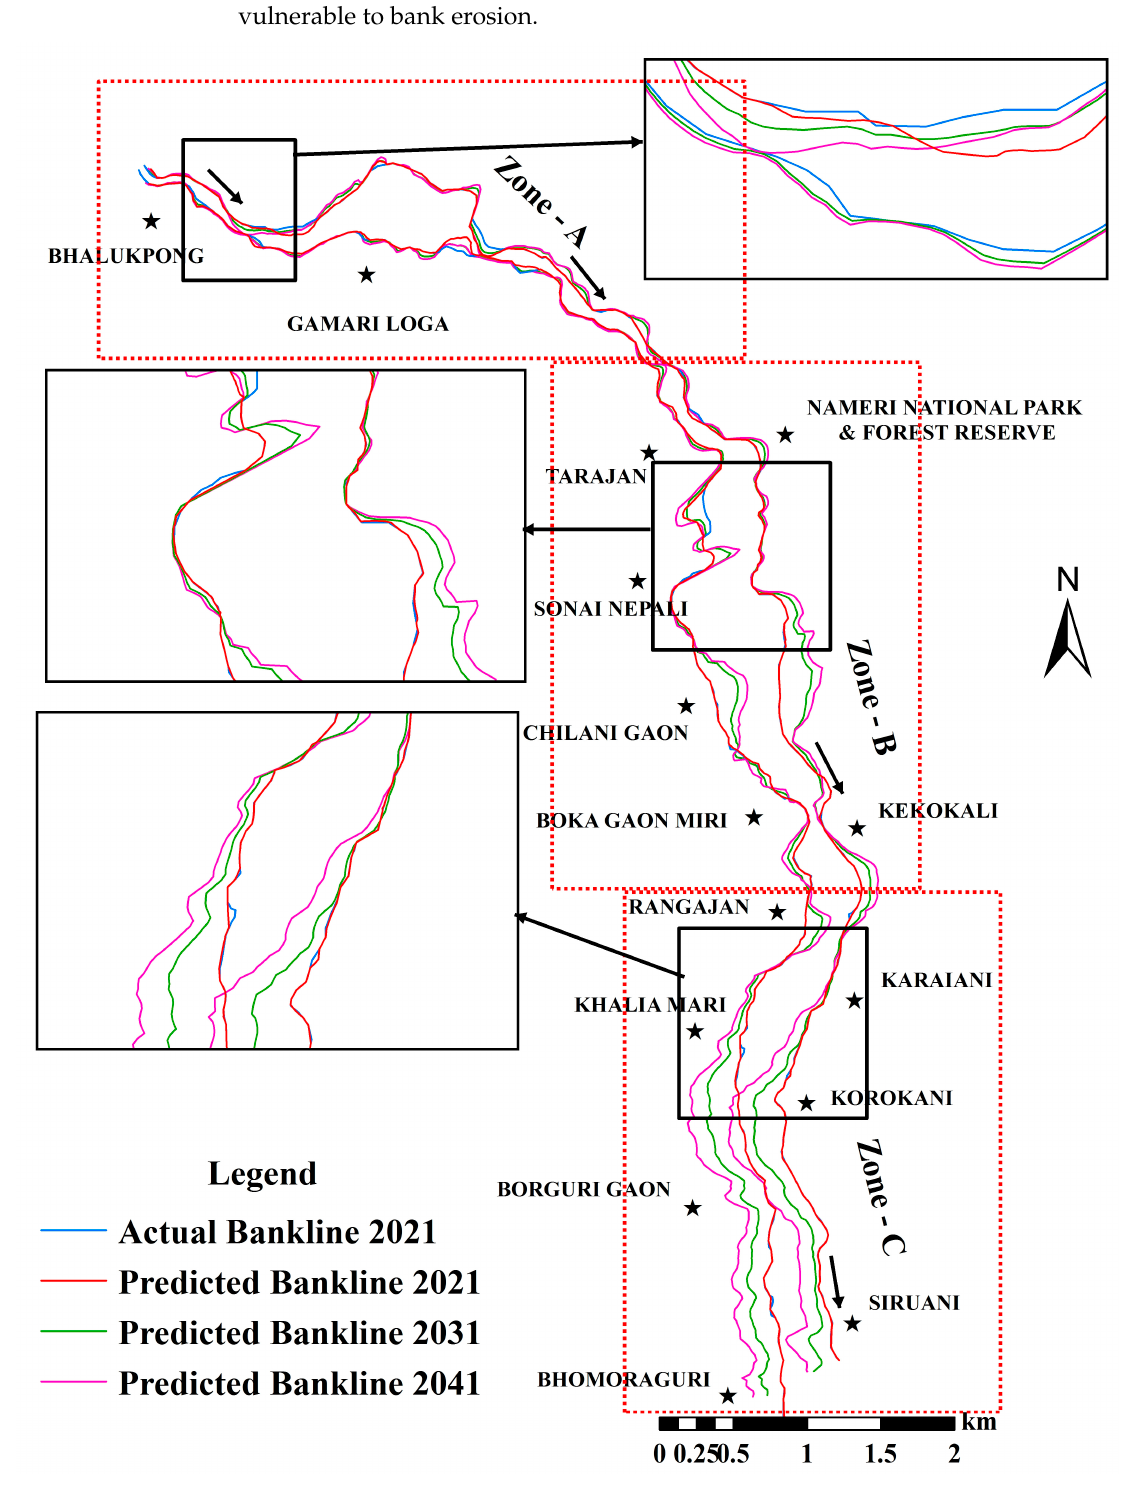
Figure 7. Right and left banklines of the Jia Bharali River were predicted using the DSAS model for the years 2021, 2031, and 2041.